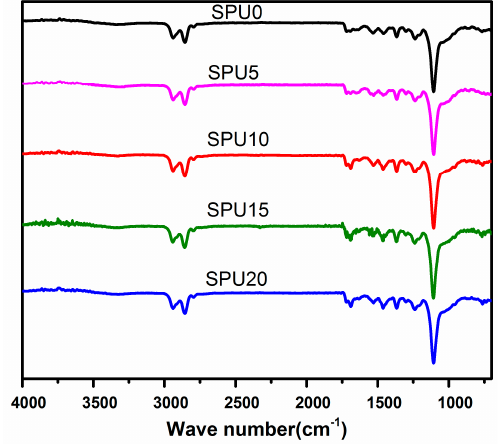
Figure 6. FT-IR of different SPU films.